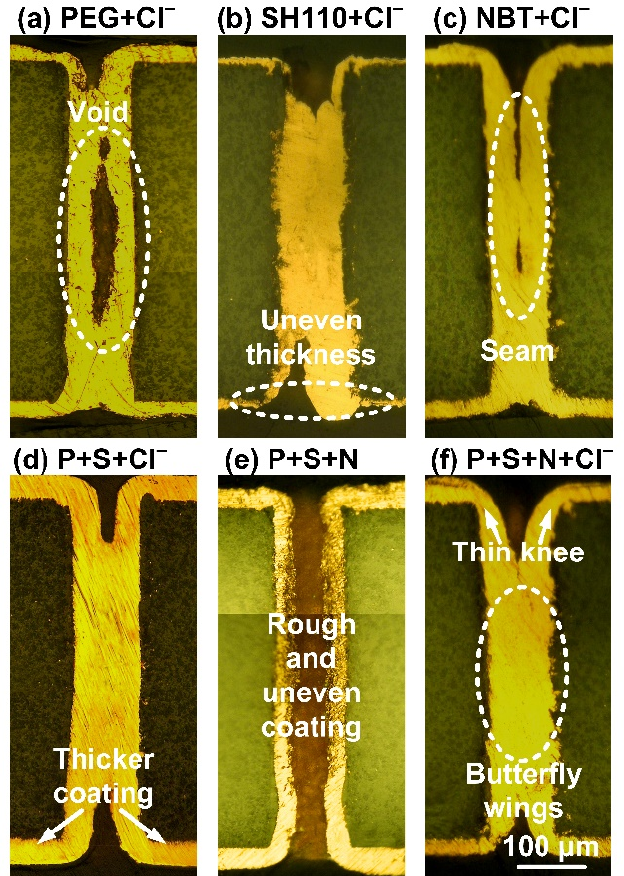
Figure 5. Cross-sections of the THs obtained using electroplating solution with different additives.